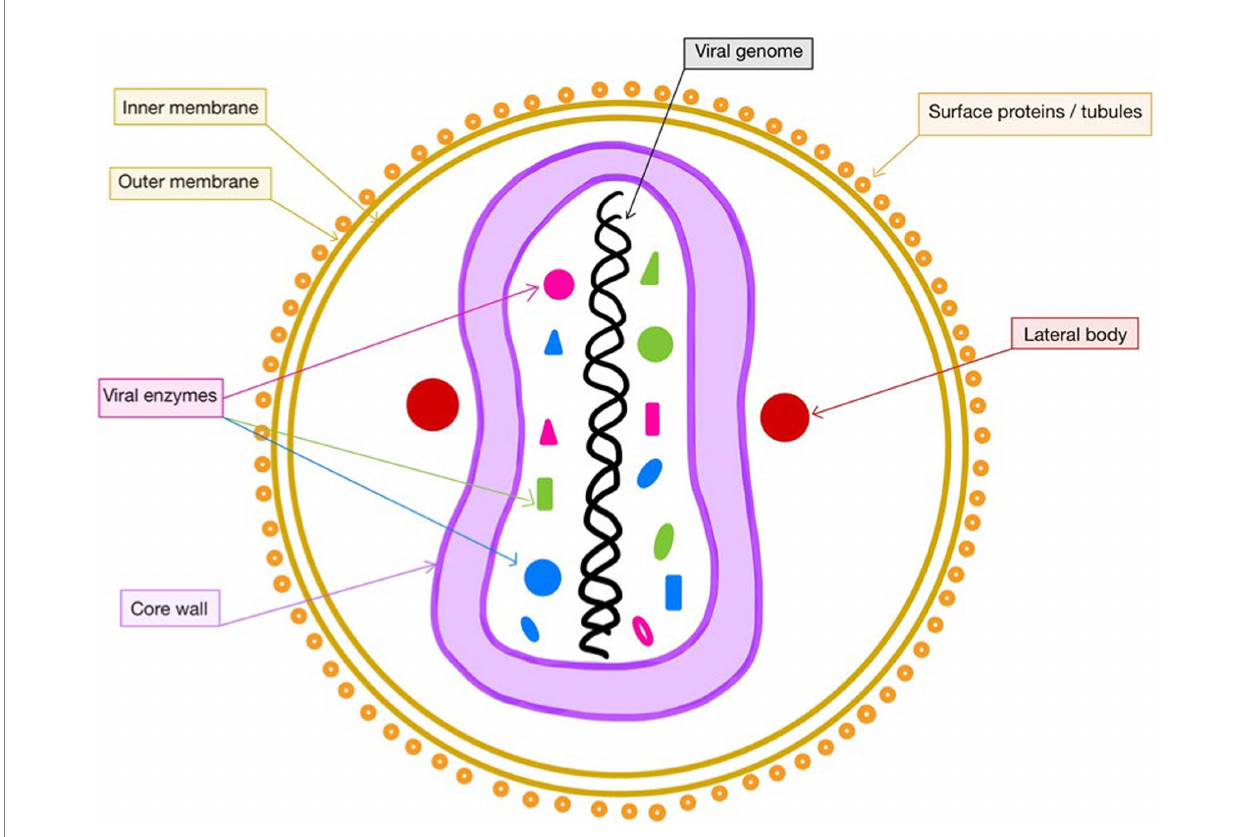
FIGURE 1 Structure of mpox. This figure was created with GoodNotes and adapted from Lu et al.